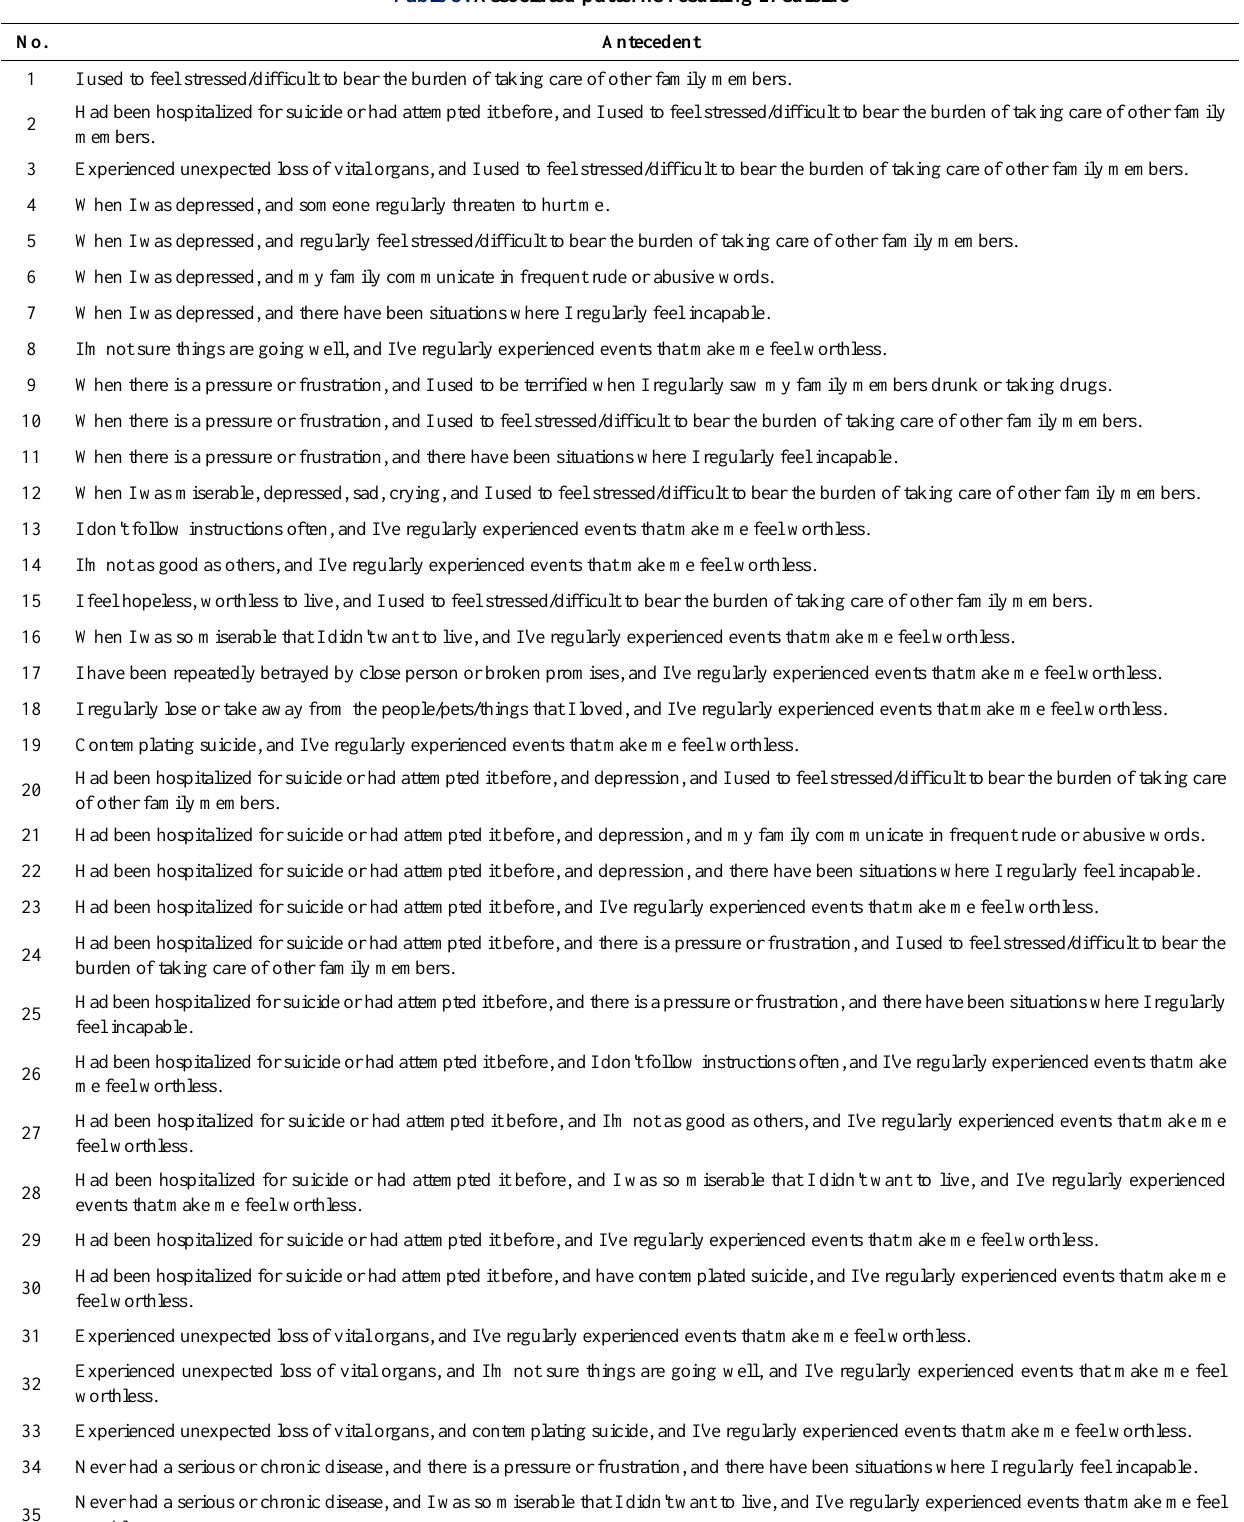
Table 3. Associated patterns resulting in